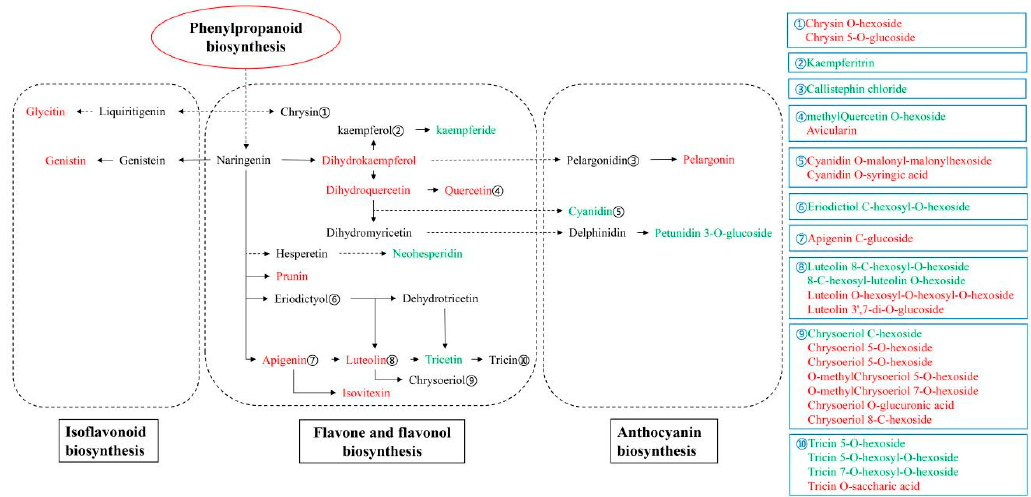
Figure 7. The differential flavonoid metabolites in the two Taxus species involved in anthocyanin biosynthesis, flavone and flavonol biosynthesis, and isoflavonoid biosynthesis. Red letters indicate the T. media predominantly accumulated metabolites; green letters indicate the T. mairei predominantly accumulated metabolites. Unannotated derivatives of flavonoid metabolites by KEGG are listed in the blue box.